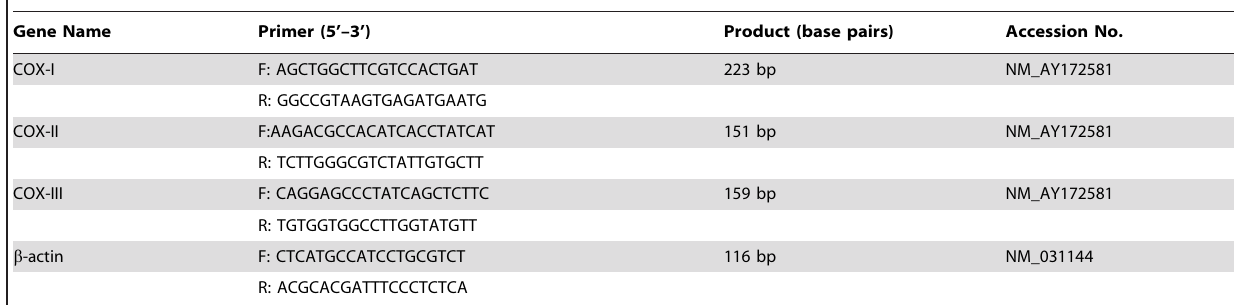
Table 1. Primers used for qRT-PCR.